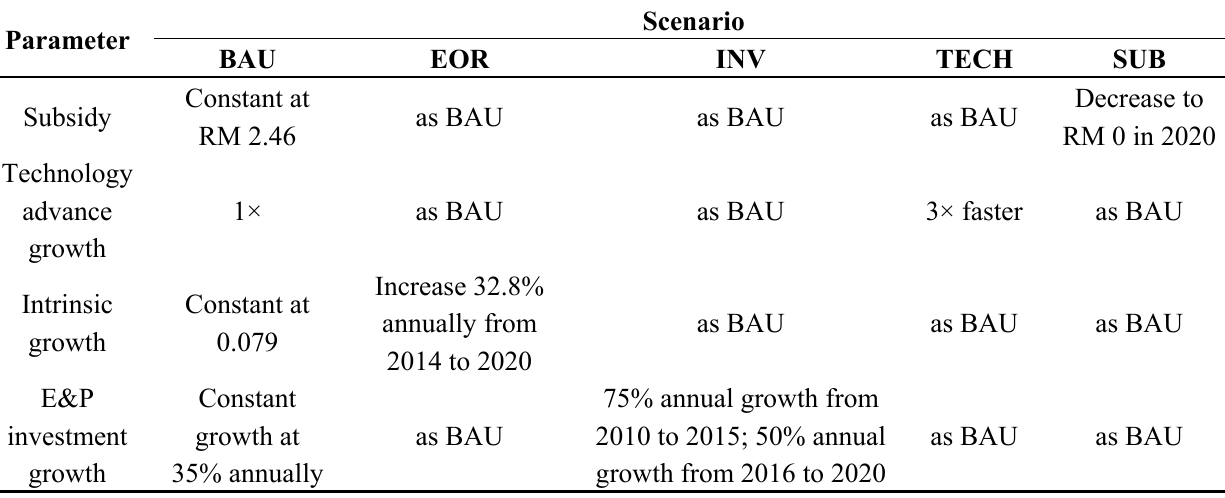
Table 4. Scenarios parameters